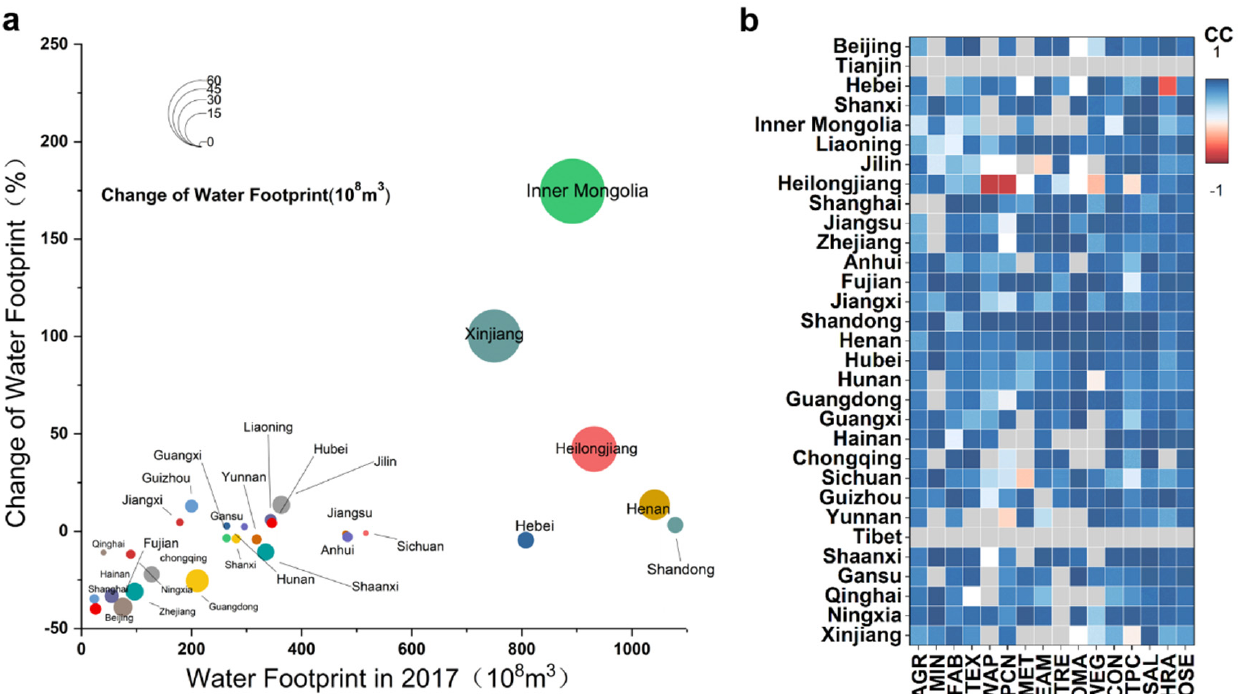
Figure 4. Evolvement on water footprint and changes in water footprint for 16 sectors from 2002 to 2017. In ( a ), the area of each circle represents the WF change, and ( b ) shows changes in water footprint for 16 the sectors. The depth of color represents the degree of change in WFI from 2002 to 2017, with Tibet and Tianjin in grey due to missing IO tables or no outputs of the corresponding sector in 2002.